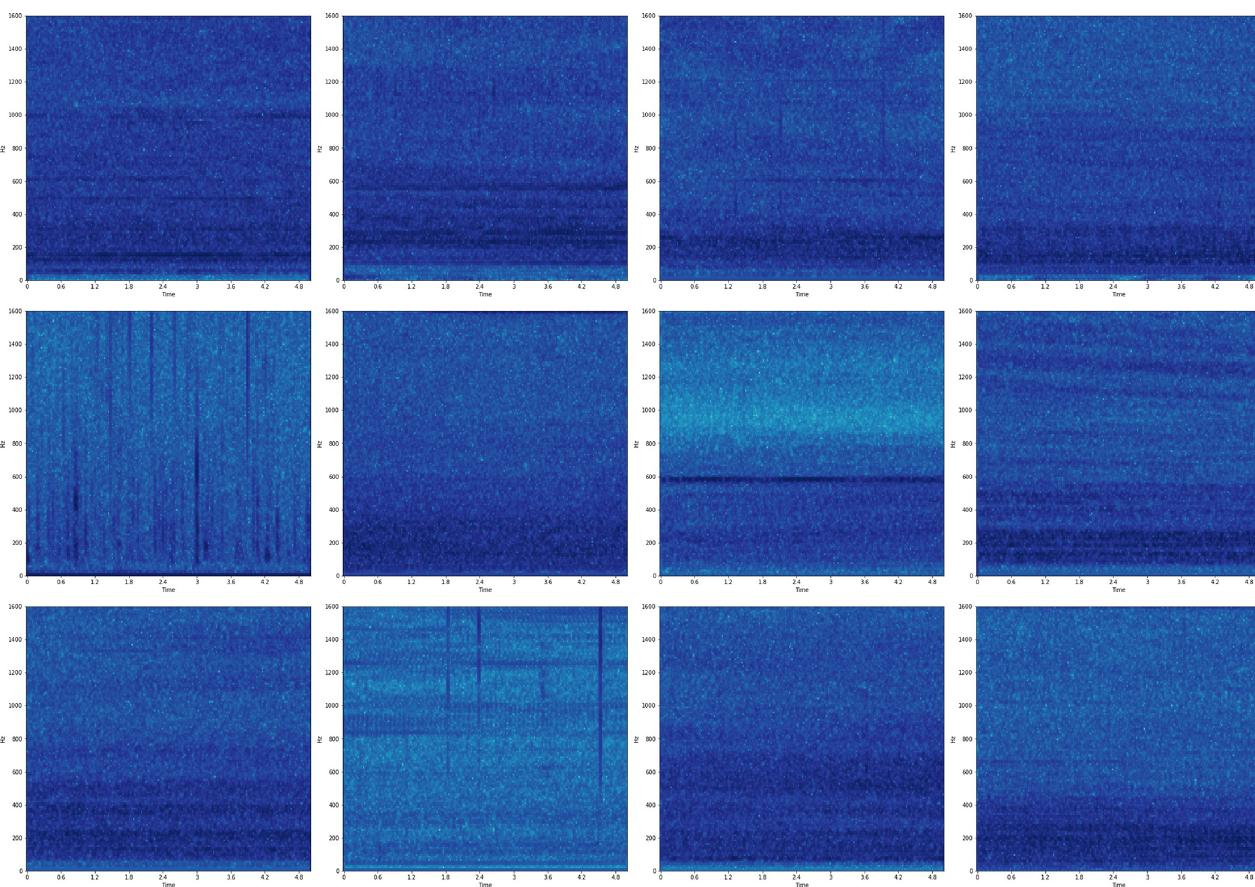
Fig 4. LOFAR spectrum of different samples. Convert raw sound data in ShipsEar database to LOFAR spectrogram.